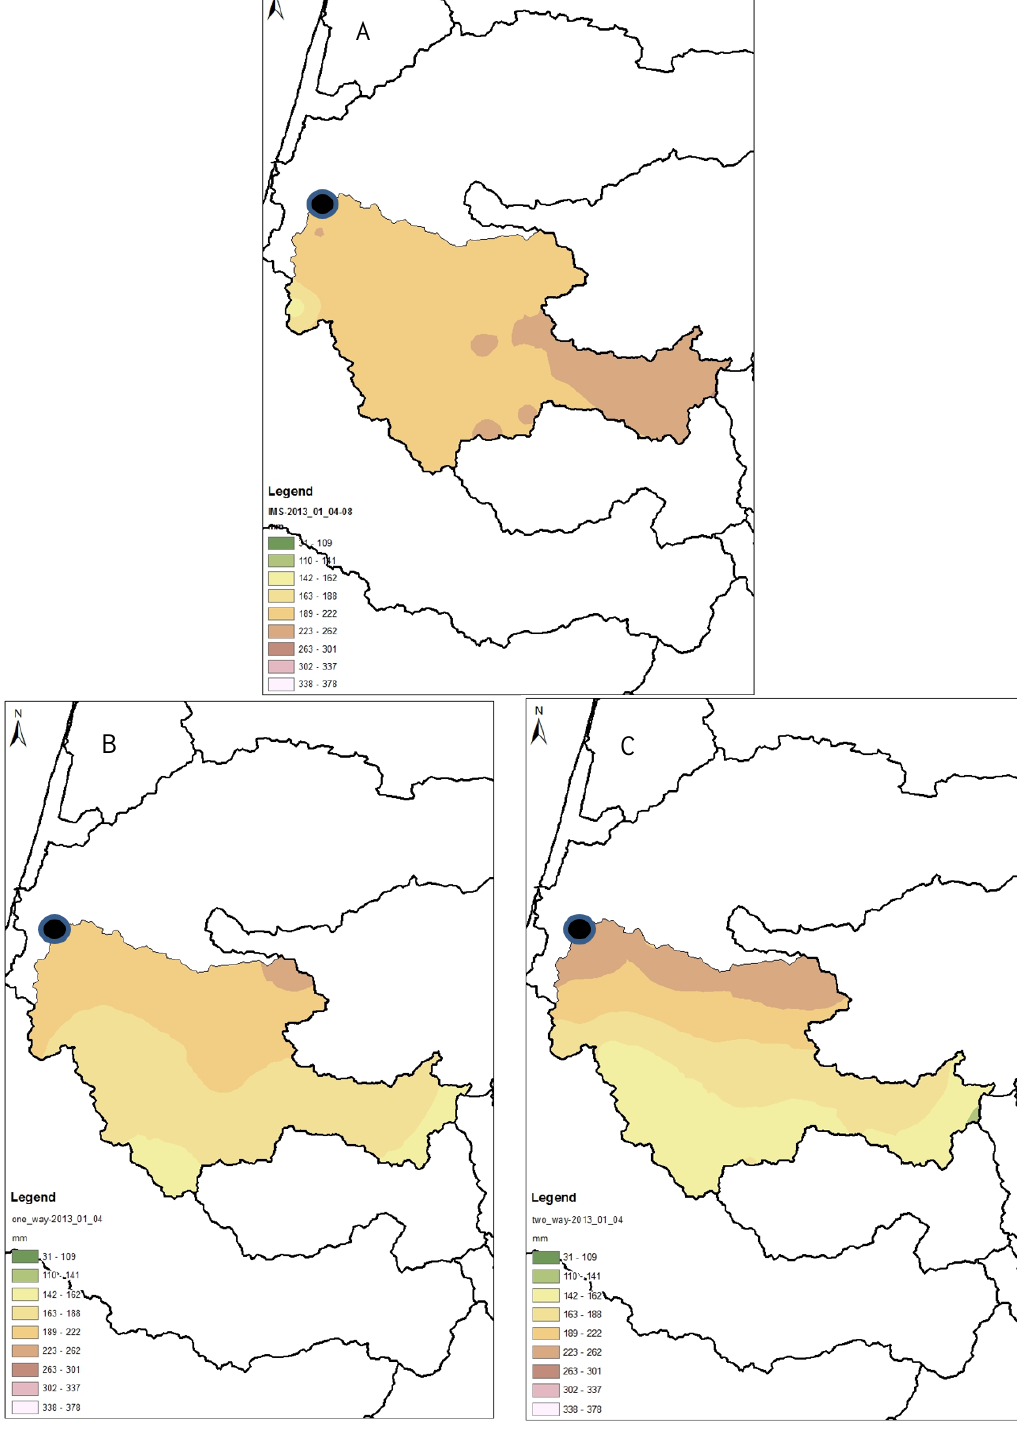
Figure 6. Accumulated observed precipitation (mm) at the Ayalon basin for the January storm ( A ); WRF one way ( B ) and WRF two way ( C ) simulated precipitation (the black dot in the figure is the Ayalon-Ezra hydrometric station at the outlet of the basin).